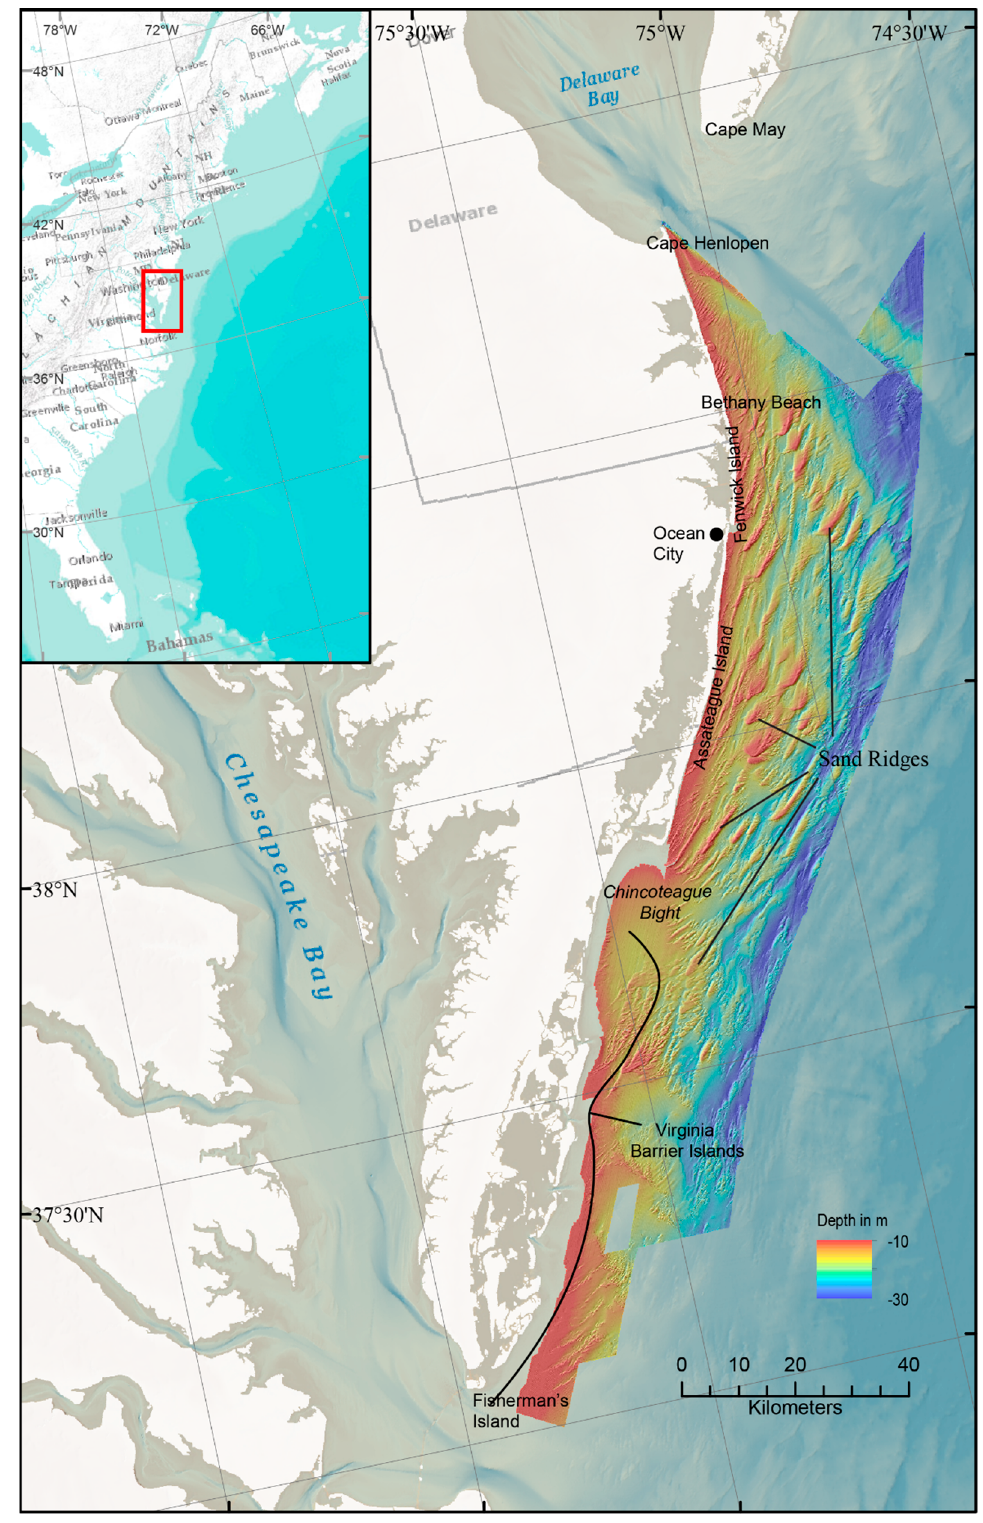
Figure 1. Map showing location of the Delmarva Peninsula and a hillslope shaded relief map [3–36] of the seafloor area to be interpreted in this study. Basemap from Esri, DeLorme, The General Bathymetric Chart of the Oceans (GEBCO), National Oceanographic and Atmospheric Administration (NOAA), National Geographic, HERE technologies, and GeoNames.